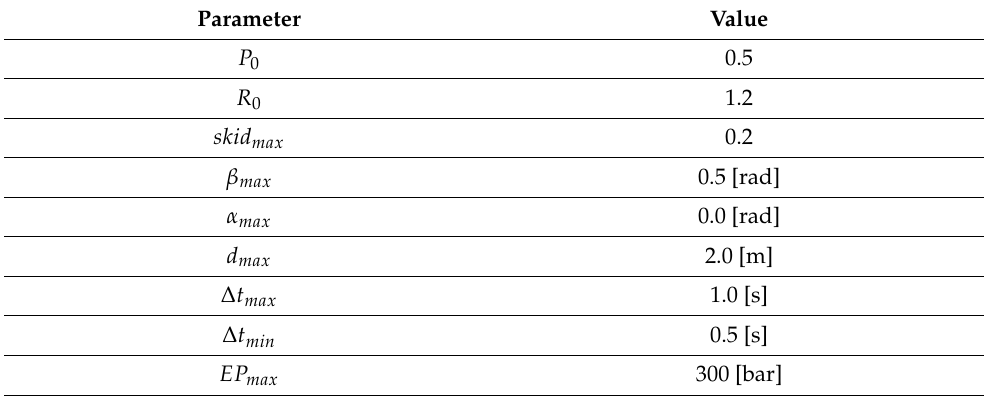
Figure 19. Pseudo code of the excavation algorithm. Table 1. Excavation method parameters used for the full-scale